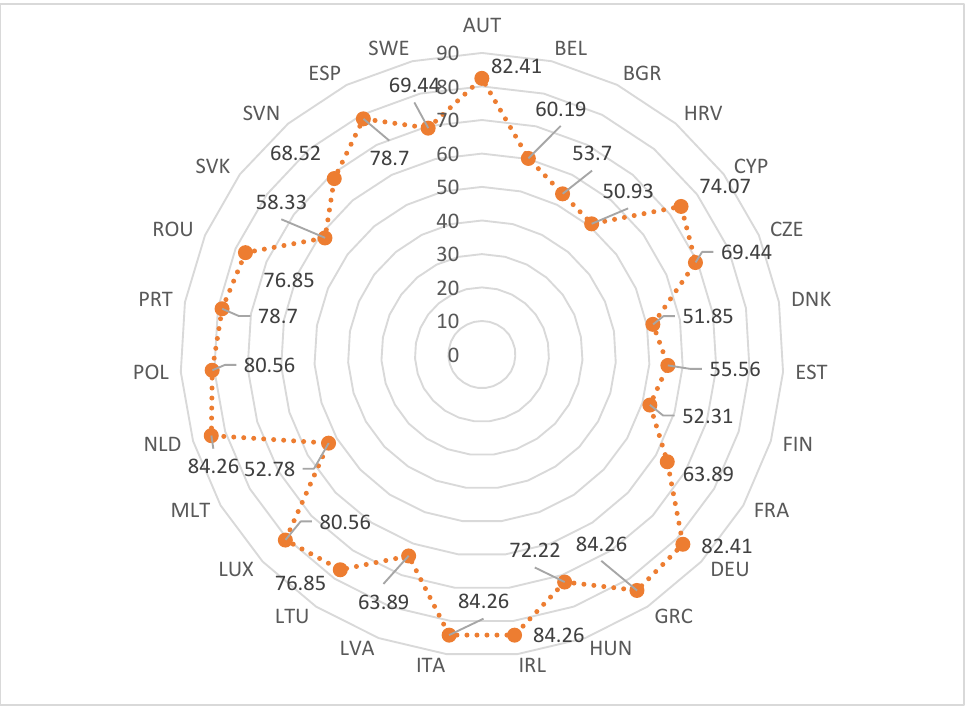
Figure 2. Stringency index on 31 December 2020 at the EU level [63].